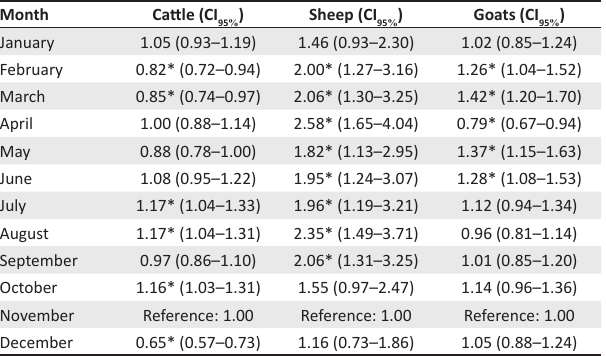
FIGURE 4: Cycle subseries plot from data of (a) cattle, (b) sheep and (c) goats slaughtered at Minna Metropolitan Abattoir, Nigeria, during the period 2001–2012. TABLE 2: Univariable logistic regression results for foetal wastage rate, ex- pressed as odds ratios, for the period 2001–2012. Data are organised according to month for each animal